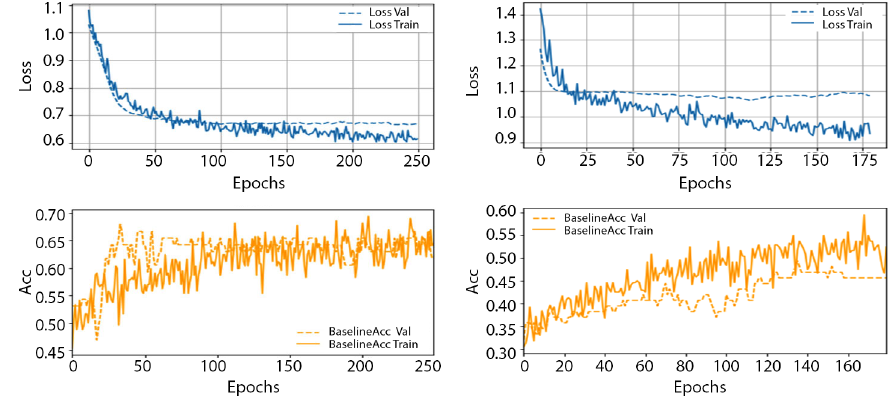
Figure 5. E2b) and E3b), classification in two, respectively 3 classes with observations from 2 years